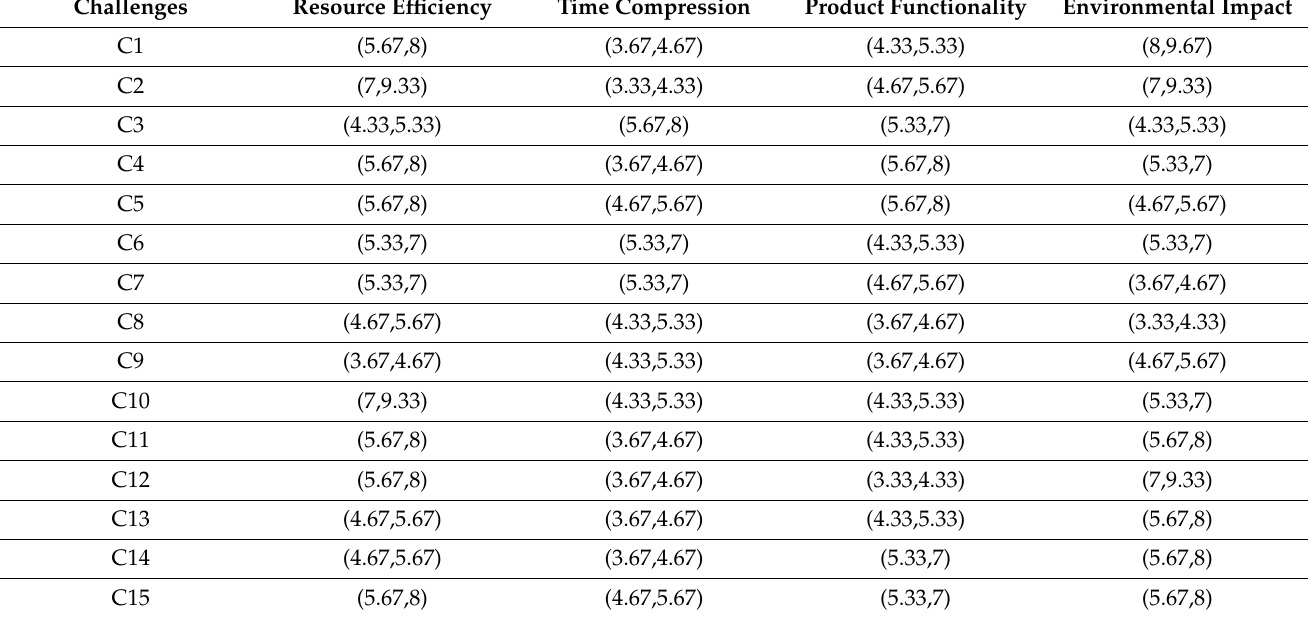
Table 5. Average ratings of the